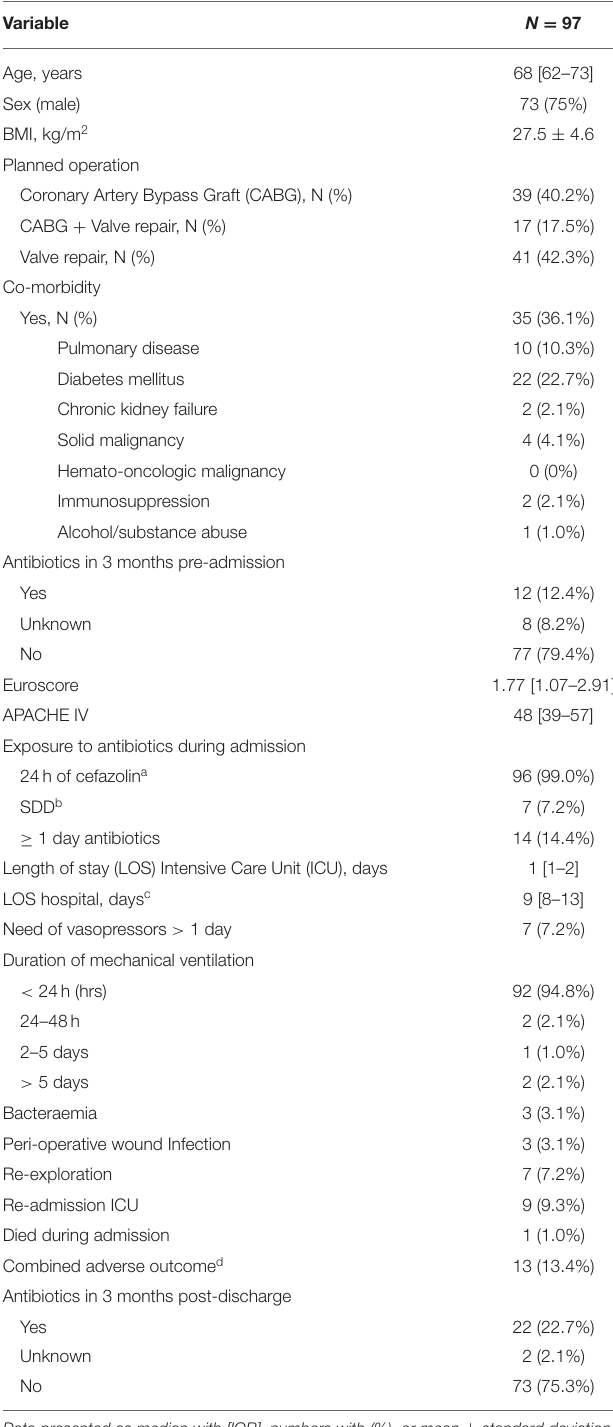
TABLE 1 | Baseline characteristics and